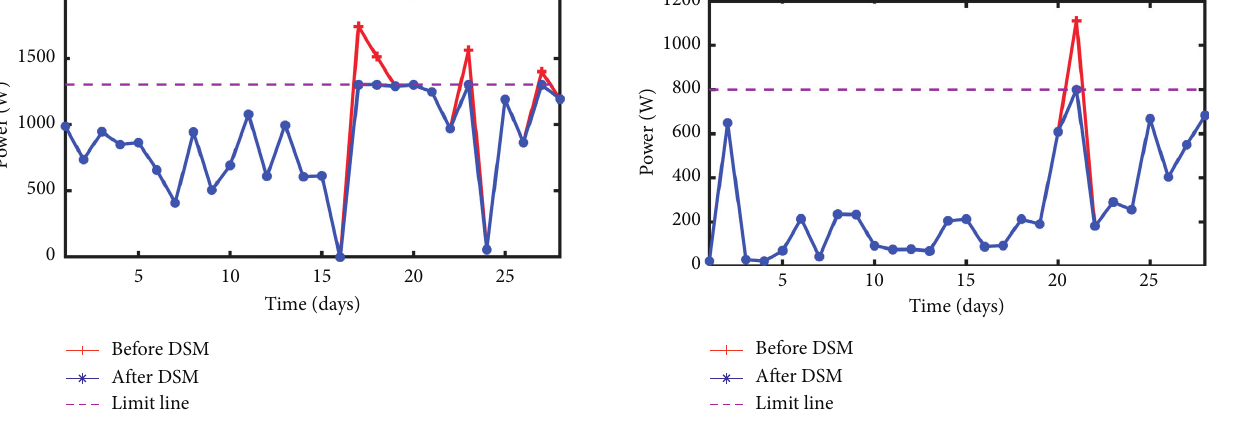
Figure 15: Load profile before and after the implementation of DSM in cluster 3.